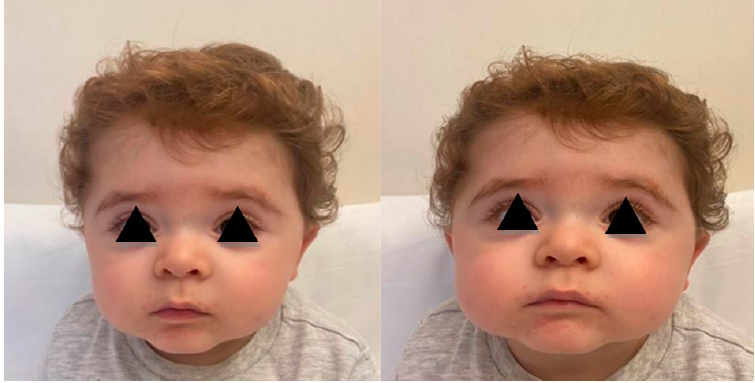
Figure 1. Case 1: Cranial and facial